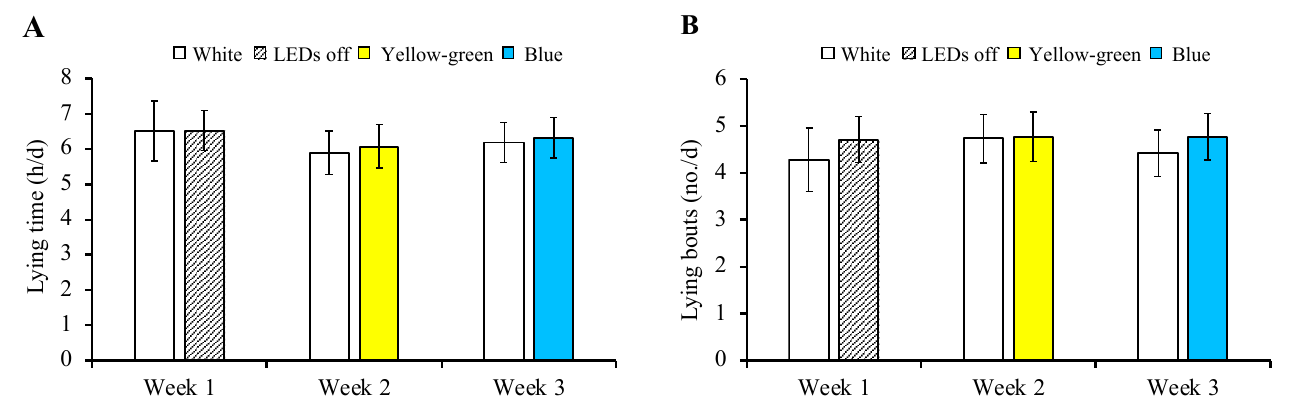
Figure 3. Least square means ± SE for daily lying time ( A ) and number of lying bouts ( B ) of 14 lactating dairy cows given free access to 2 different LED light options each week in a 3-week preference test. Weeks comprised 3 days of no light (adaptation) and 4 days of treatments. White light had a spectral distribution of 380–780 nm (full-spectrum), yellow-green light had a wavelength of 564 nm, and blue light had a wavelength of 483 nm. The white lights tested in weeks 2 and 3 were adjusted to a lux similar to that of the colours tested.